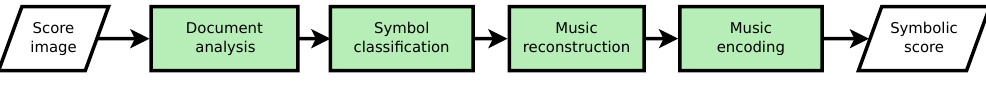
Figure 1. Traditional workflow for Optical Music